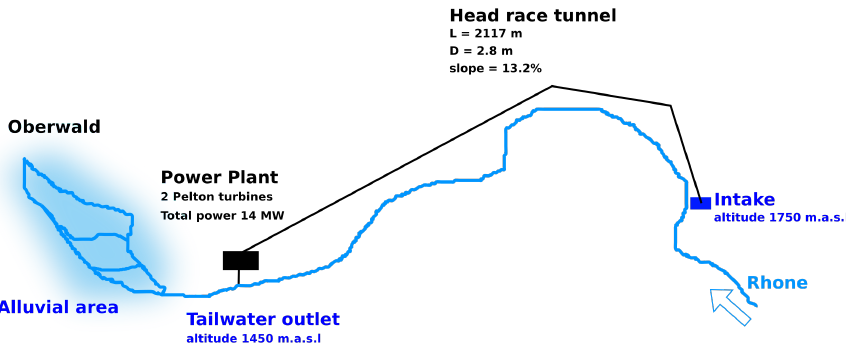
Figure 1. Schematic representation of the KWGO power plant